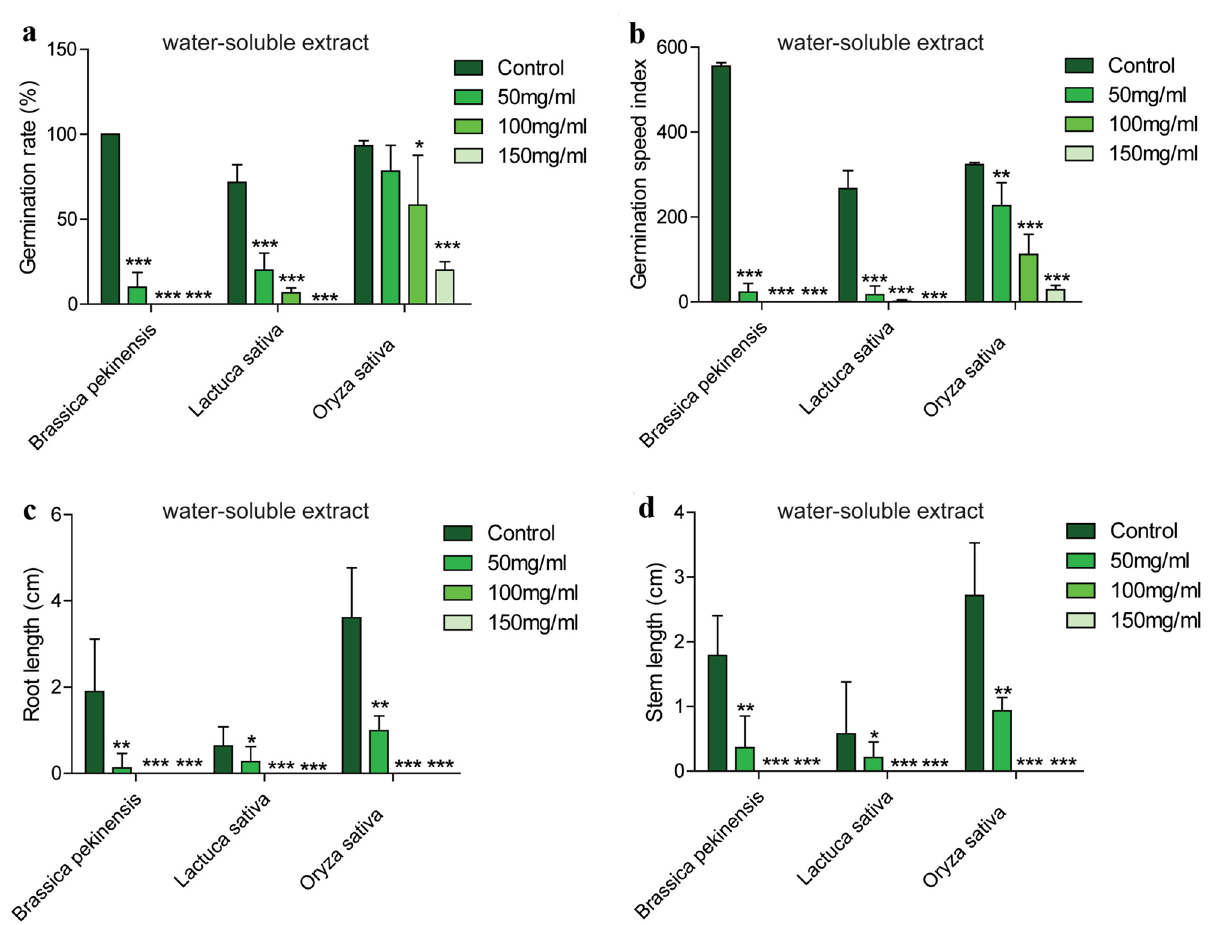
Figure 3. The water-soluble extract of A. argyi inhibits the germination and growth of Brassica pekinensis , Lactuca sativa and Oryza sativa . Specific performance is in a series of indicators: ( a ) the germination rate, ( b